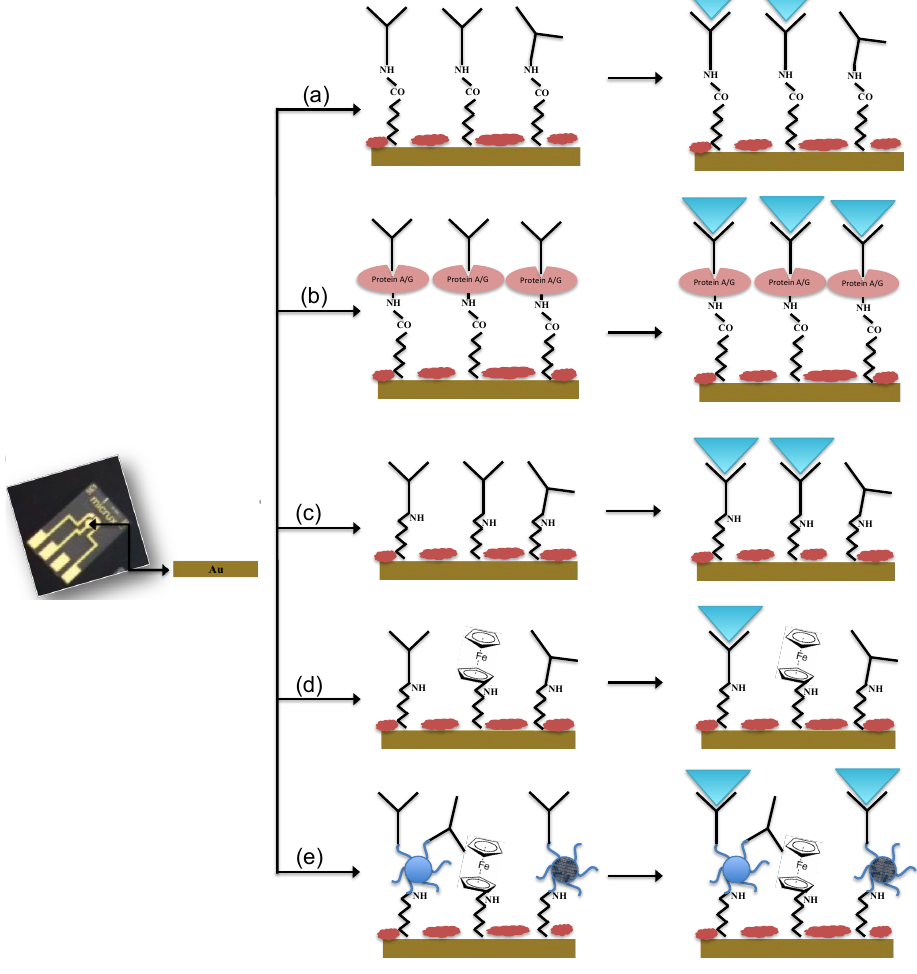
Figure 1. Schematic diagrams of immunosensors fabrication: ( a ) Not oriented anti- E. coli O157:H7 on MBA self-assembled monolayer (Au-MBA-Ab); ( b ) Oriented anti- E. coli O157:H7 on MBA self-assembled monolayer (Au-MBA-ProteinA/G-Ab); ( c ) Anti- E. coli O157:H7 on electrochemically deposited cysteamine layers (Au-Cys-Ab); ( d ) Anti- E. coli O157:H7 on cysteamine and ferrocene layers (Au-Cys-Ferrocene-Ab); ( e )Anti- E. coli O157:H7 on PAMAM and ferrocene layers (Au-Cys-PAMAM-Ferrocene-Ab).